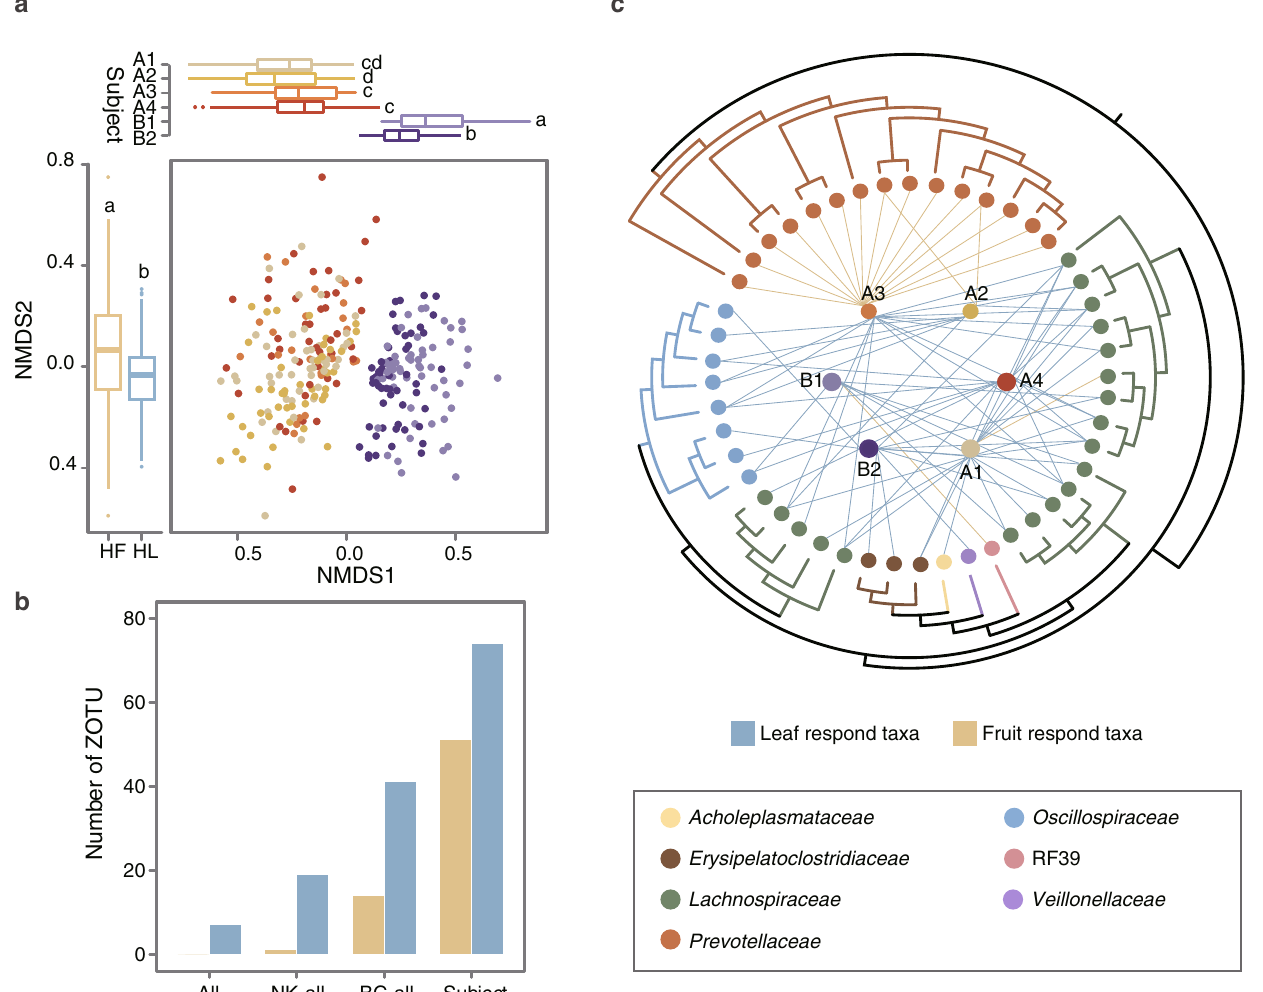
Fig. 4 Covariation of diet and gut microbiota across the individuals. a NMDS (center panel) of the Bray – Curtis dissimilarity based on the microbial community composition. Different colors corresponded to different gibbon individuals in the top panel. Boxplots (top panel) indicated the distribution of each individual along the fi rst axis of NMDS. The boxplots on the left panel depicted different diet types according to their gut microbial community placement on the second axis of NMDS. Different letters represented signi fi cant differences (ANOVA followed by Duncan ’ s test). b The number of the diet-speci fi c responsive ZOTUs. Colors indicated the types of responsive ZOTUs (yellow, responding to fruit; blue, responding to leaf). c Within-individual correlations between diet and the relative abundances of ZOTUs (Spearman ’ s correlation r > 0.6; FDR-corrected p -value < 0.01). The colored circles in the middle represented different gibbon individuals. The tree outside was obtained by 16S rRNA gene sequences, and the colors represented diverse microbial families. The lines with different colors indicated the types of